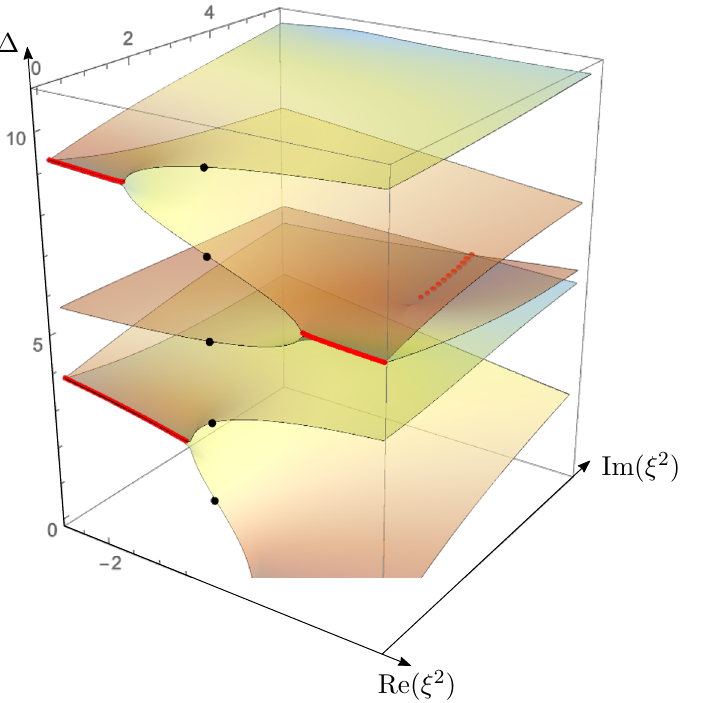
Figure 17 . Spectrum of the one-magnon family of operators as a function of a complexi(cid:12)ed coupling (cid:24) 2 . All the operators, corresponding to di(cid:11)erent combinations of (cid:12)elds at weak coupling (black dots) in fact belong to the same Riemann surface and can be obtained as an analytic continuation in (cid:24) 2 from one another. The plot is done for (cid:18) =